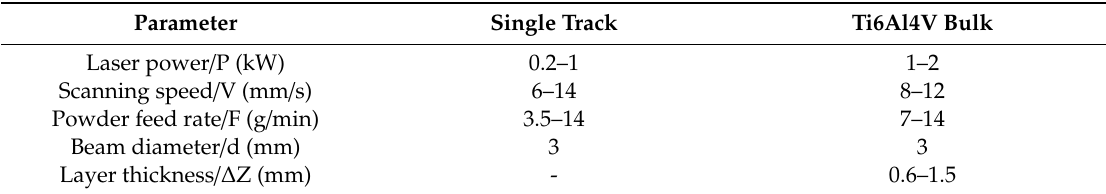
Table 2. Laser melting deposition (LMD) processing parameters of the Ti6Al4V single track and bulk. Parameter Single Track Ti6Al4V Bulk Laser power / P (kW) 0.2–1 1–2 Scanning speed / V (mm /